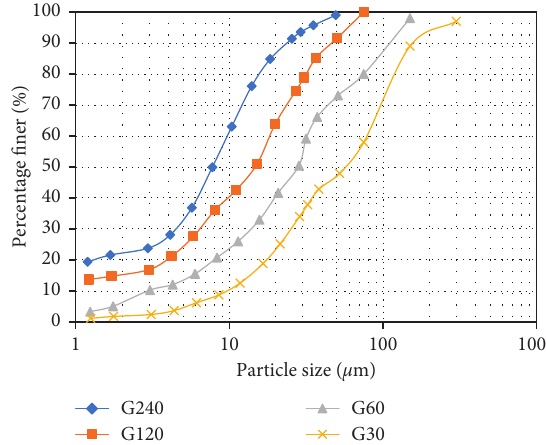
Figure 15: Particle size distribution of mix ash at different grinding